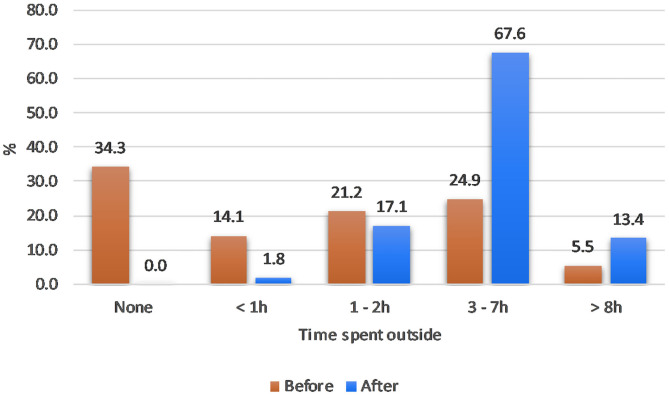
Percentage of cats that spent time outside according to each time interval before vs. after the installation of one of the ProtectaPet® systems for controlled environment.